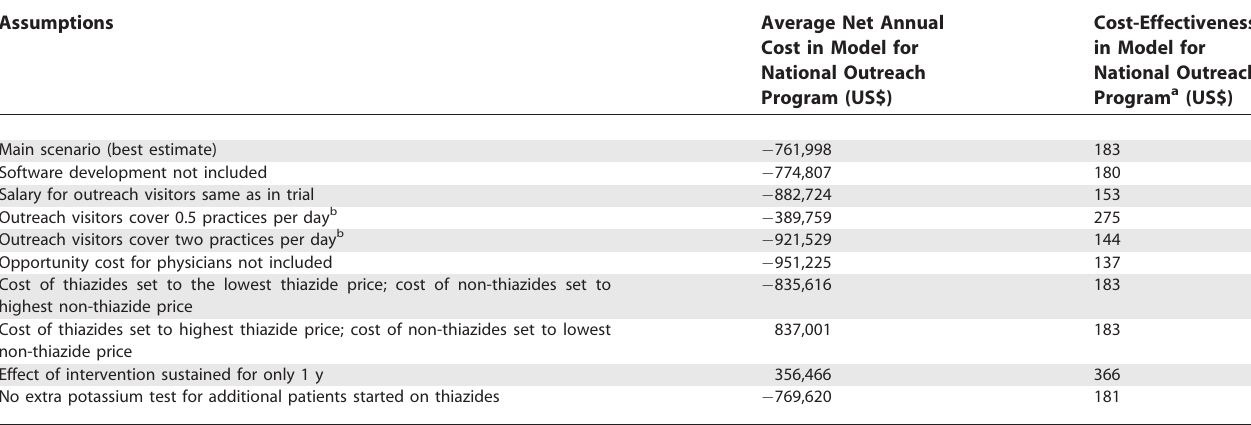
Table 7. Univariate Sensitivity Analyses in Model for Scaling Up to National Program